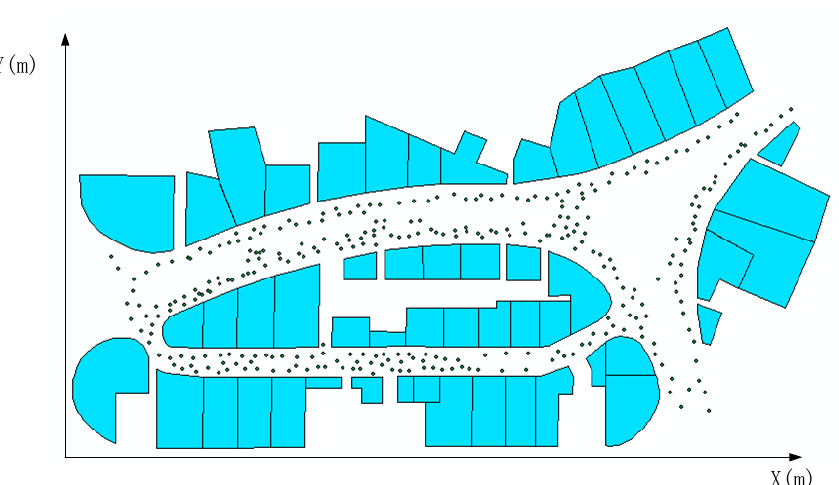
Figure 9. Distribution of the location points.